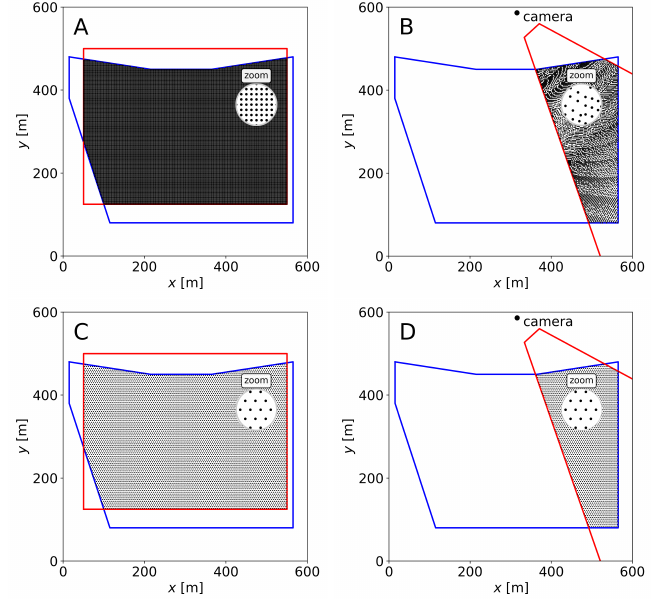
Figure 2. Meshes for modes ( top ) and wavenumbers ( bottom ) for videos made up of planviews ( A , C ) and raw images ( B , D ). The bathymetry domain is shown in blue; planview ( A , C ) or camera ( B , D ) domains are shown in red.